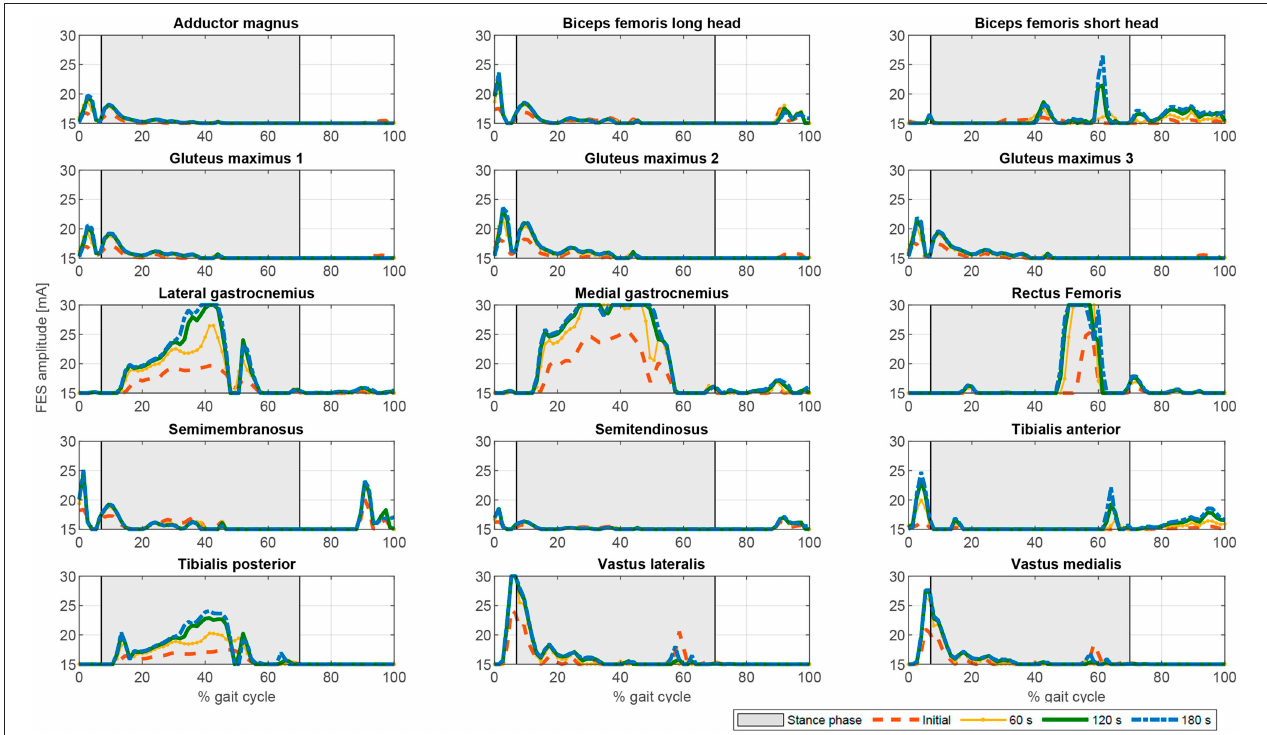
FIGURE 6 | Evolution of the FES profiles for the proposed muscles using exponential decay fatigue factor for function F 1 . Dashed orange line: Initial FES profile. Dotted yellow line: FES profile at 60 s. Solid green line: FES profile at 120 s. Dash-dotted blue line: FES profile at 180 s.